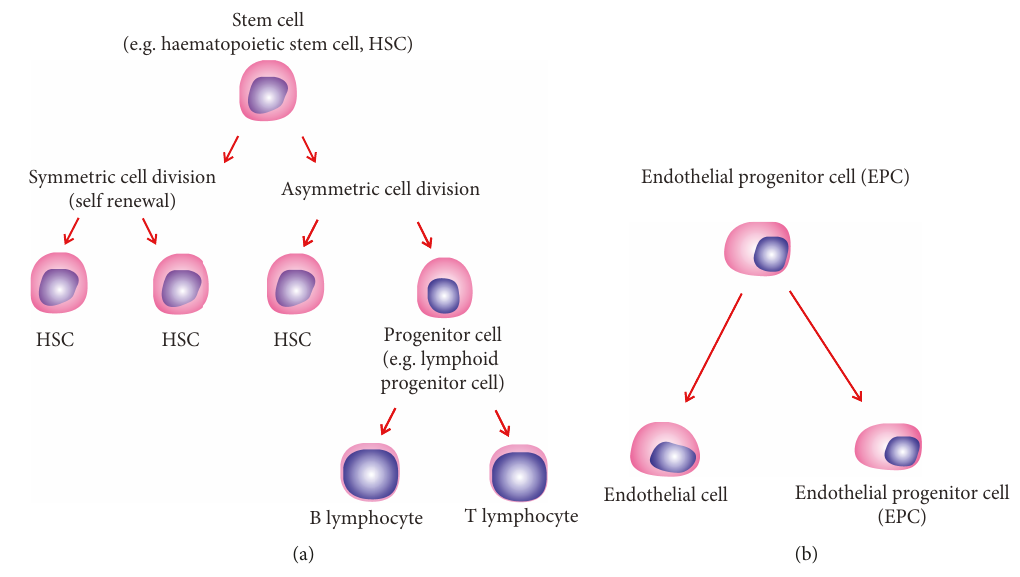
Figure 1: Di ff erence between stem cells and progenitor